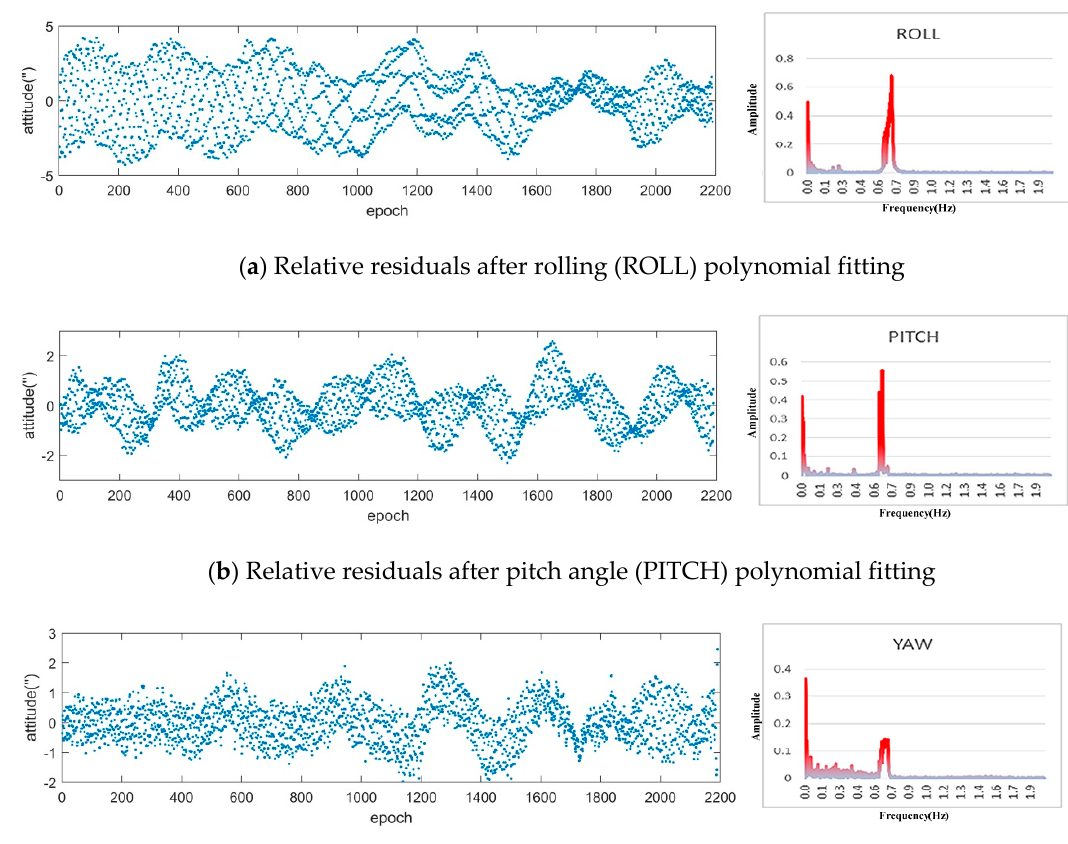
Figure 7. Stellar map data analysis results.